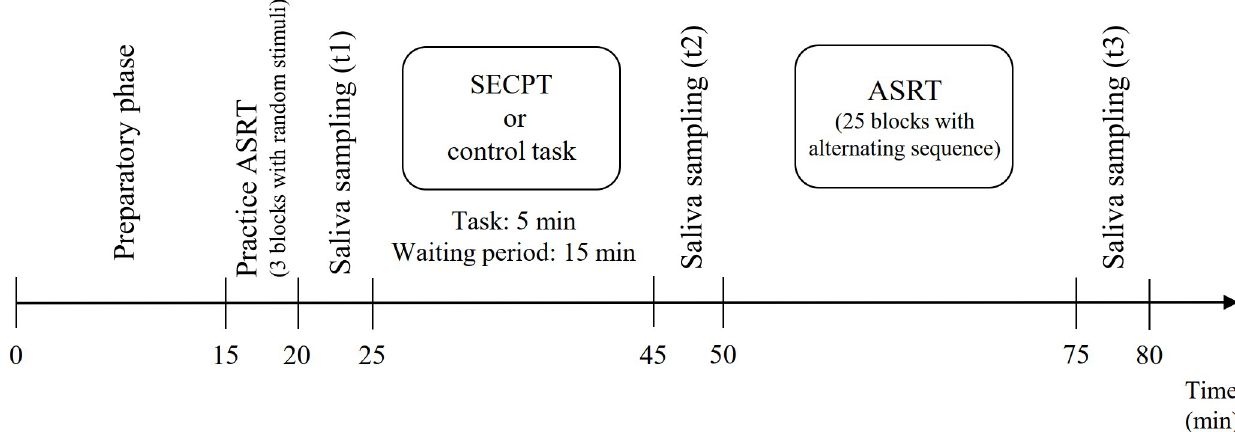
Fig 1. Experimental procedure. Cortisol levels were assessed from saliva at three time points: immediately before the stress induction or control task (t1), 15 minutes after the stress induction or control task (t2), and immediately after the ASRT task, ca. 45 minutes after the stress induction or control task (t3). ASRT: Alternating Serial Reaction Time task; SECPT: Socially Evaluated Cold Pressor